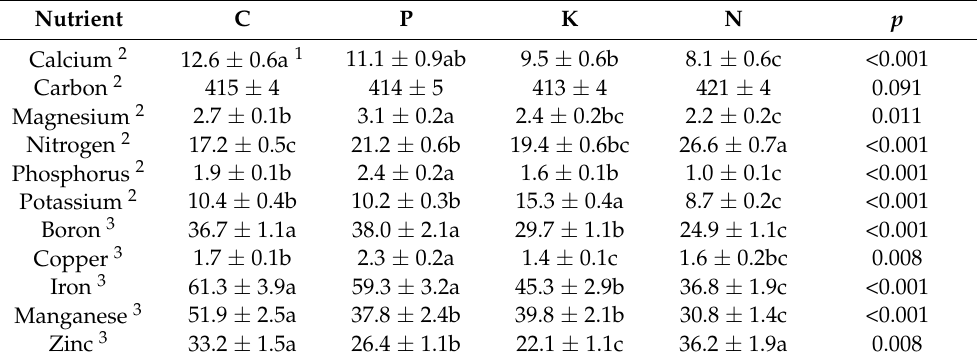
Table 1. The influence of N, P, or K fertilization on nutrient concentrations of Serianthes kanehirae leaves. C = control; P = phosphorus fertilization; K = potassium fertilization; N = nitrogen fertilization. Mean ± SE, n = 6.